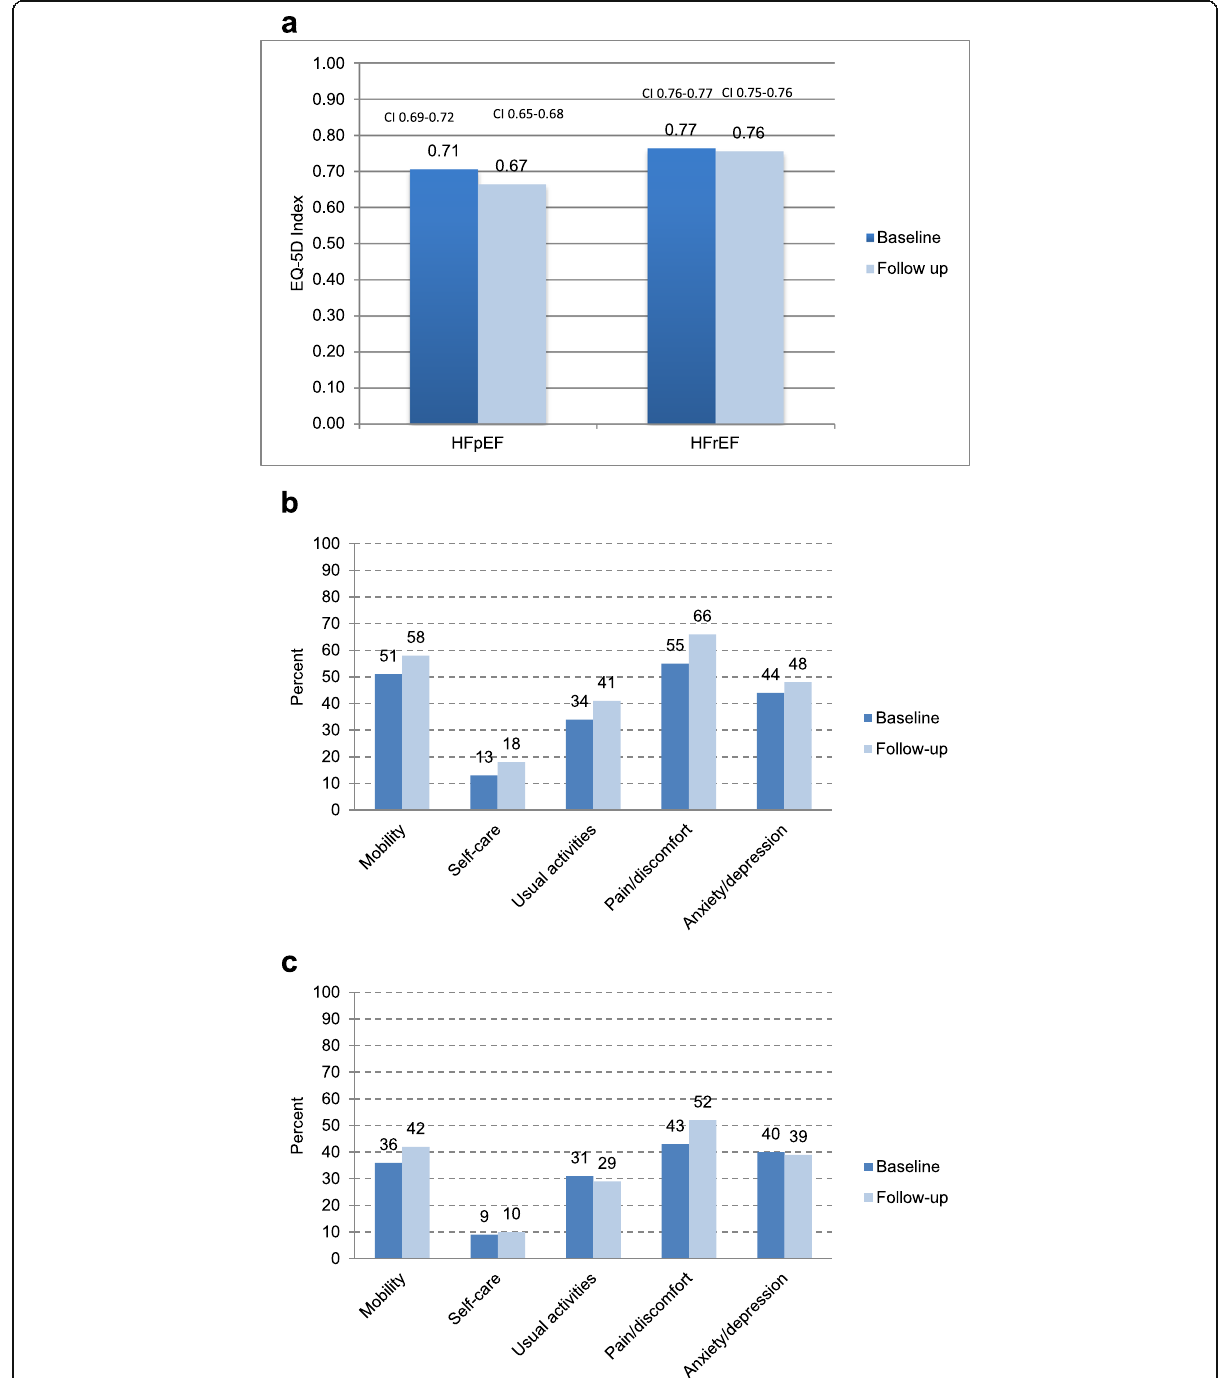
Fig. 2 a Mean levels of EQ-5D index with confidence intervals in the two study groups, HFpEF (EF > 50%) and HFrEF (EF < 40%) at baseline and at follow up. b Proportions of patients with HFpEF (EF > 50%) reporting at least some problems (levels 2 or 3) for each dimension of EQ-5D at baseline and at follow up. c Proportions of patients with HFrEF (EF < 40%) reporting at least some problems (levels 2 or 3) for each dimension of EQ-5D, at baseline and at follow